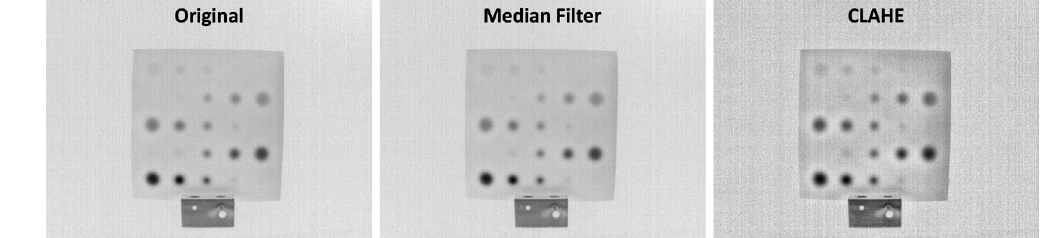
Figure 9. Effects of median filter and CLAHE.